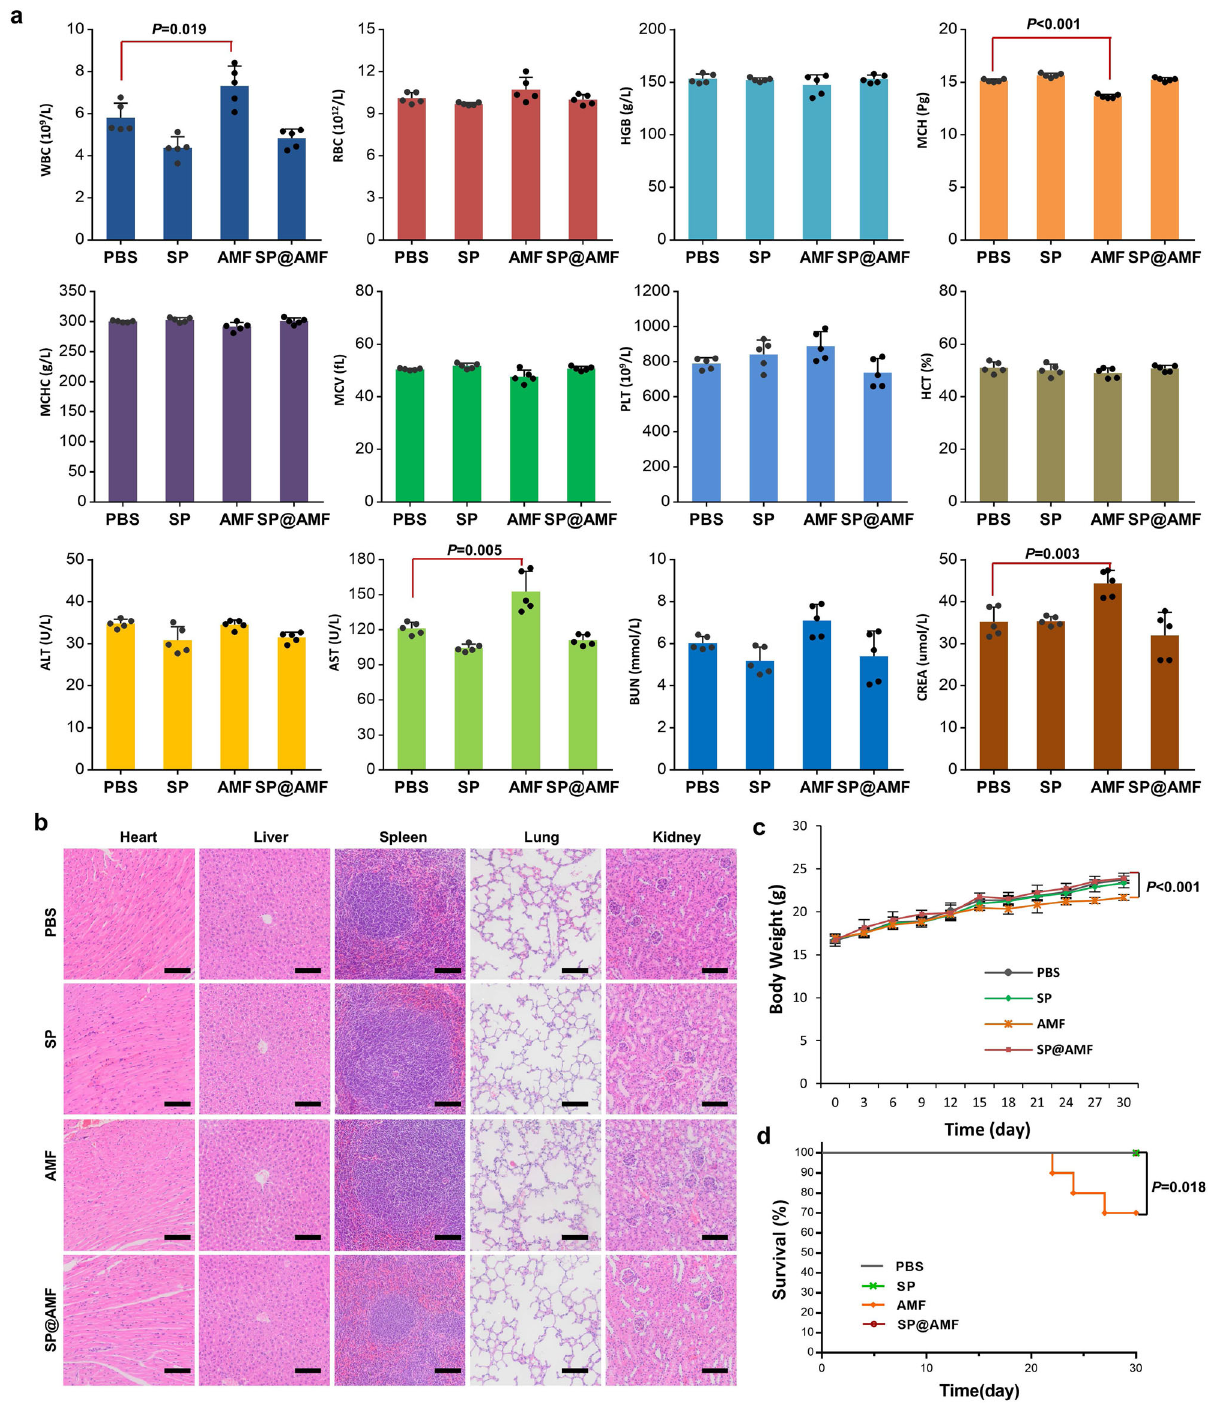
Fig. 9 SP@AMF shows higher security in long-term use compared with AMF. a Hematological tests and serum biochemicals tests of the mice after the daily administration of PBS, SP, AMF, or SP@AMF for 30 days ( n = 5 biologically independent animals). The data show means + SD. P was calculated using two-tailed t -test. WBC white blood cells, RBC red blood cells, HGB hemoglobin, MCH mean corpuscular hemoglobin, MCHC mean corpuscular hemoglobin concentration, MCV mean cell volume, PLT blood platelet, HCT hematocrit, ALT alanine transferase, AST aspartate transferase, BUN blood urea nitrogen, CREA creatinine. b Represented HE images of the major organs of the mice after different treatments for 30 days. Scale bar = 200 μ m. Experiment was repeated three times independently with similar results. c Body weight of mice ( n = 5 biologically independent animals). The data show means ± SD. P was calculated using two-tailed t -test. d survival curves of mice ( n = 10 biologically independent animals). Median survival: PBS, unde fi ned (>30 days); SP, unde fi ned (> 30 days); AMF, unde fi ned (>30 days); SP@AMF, unde fi ned (>30 days). P was calculated using Log-rank (Mantel-Cox) test.